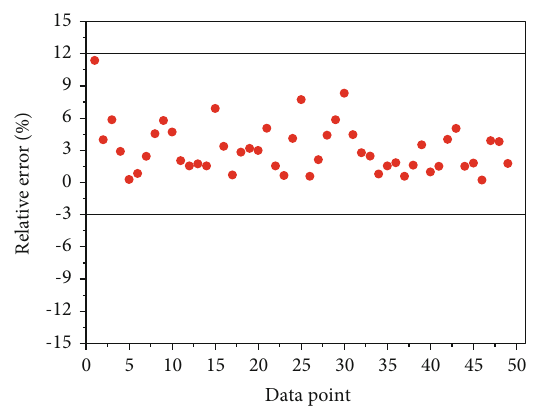
Figure 10: Error of the prediction model and simulation